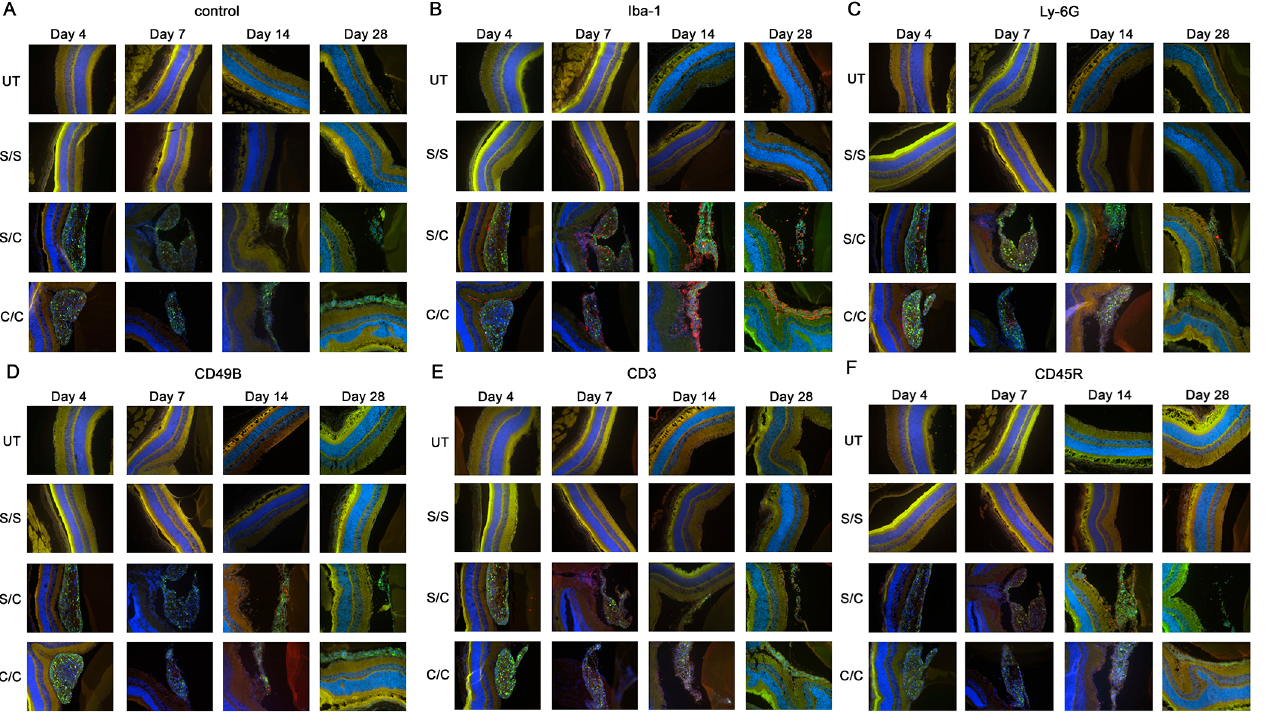
Figure 2. Immuno-labeling of infiltrated immune cells by treatment group. Immunofluorescent images of ( A ) control sections (secondary antibody alone), ( B ) anti-Iba-1 (activated macrophage and microglia marker), ( C ) anti-Ly-6G (neutrophil marker), ( D ) anti-CD49b (natural killer cell marker), ( E ) antibodies anti-CD3 (T cell marker), and ( F ) anti-CD45R (B cell marker) are displayed in the figure. The limited red signals present indicate positive antibody labeling for leucocyte markers, green signals indicate the gmRPC grafts, and blue signals indicate DAPI nuclear labeling. Yellow is nonspecific overlap of signals, most obvious in the photoreceptor outer segments which exhibit autofluorescence. Treatment groups: untreated (UT), both eyes untreated; S/S, both eyes sham treated (sequentially) with vehicle; S/C, right eye injected with vehicle followed by left eye with 50,000 gmRPCs and; C/C, both eyes injected with 50,000 gmRPCs (sequentially) per schedule in Section 4.